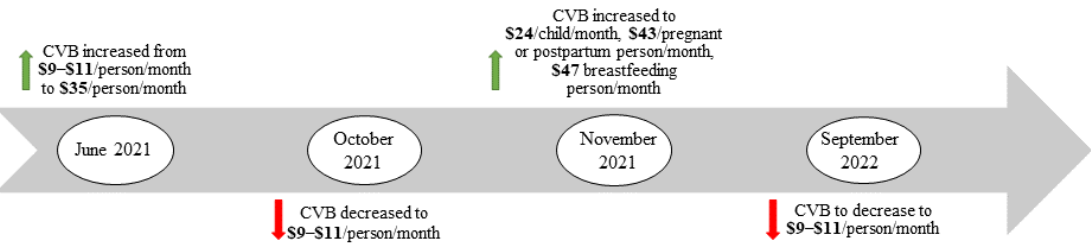
Figure 1. Timeline of key CVB changes between 2021 and 2022 in North Carolina.